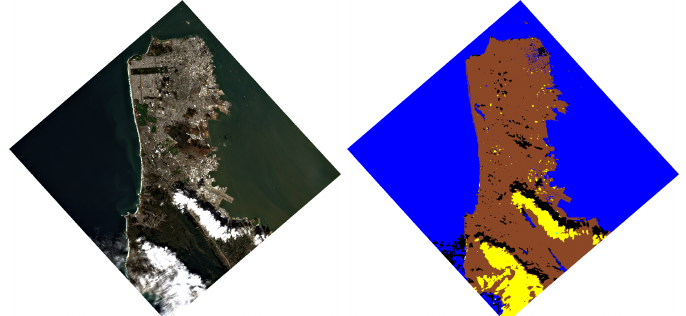
Figure 4. DESIS scene of San Francisco bay (10 October 2018): ( Left ) RGB map of the scene (R: 640 nm, G: 550 nm, B: 461 nm); and ( Right ) color composite of the masks relevant for this scene: land (2) in brown, water (8) in blue, shadows (1) in black and clouds (6 and 7) in yellow. The scene background is represented in white in both